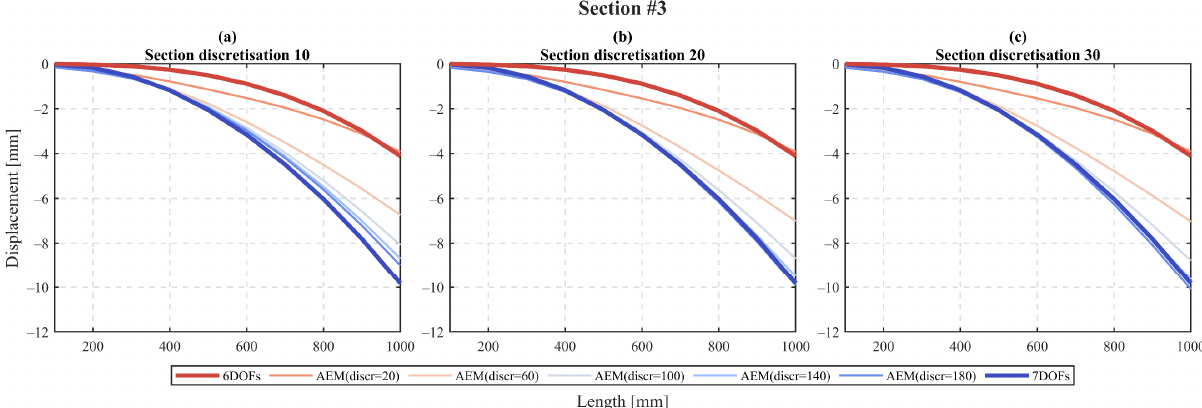
tion point of view. It is worth noting that the initial displacements for the shorter length (L = 100 mm) are reduced to − 0.16 mm, − 0.18 mm and − 0.18 mm for AEM (discr = 180) and all the section discretisation options, respectively, while 6DOFs and 7DOFs formulations provide 0 mm and − 0.02 mm. Taking into account the larger length (L = 1000 mm), a com- parison of the same kind leads to values of − 8.99 mm, − 9.91 mm and − 10.09 mm for AEM and − 4.11 mm and − 9.82 mm for 6DOFs and 7DOFs.